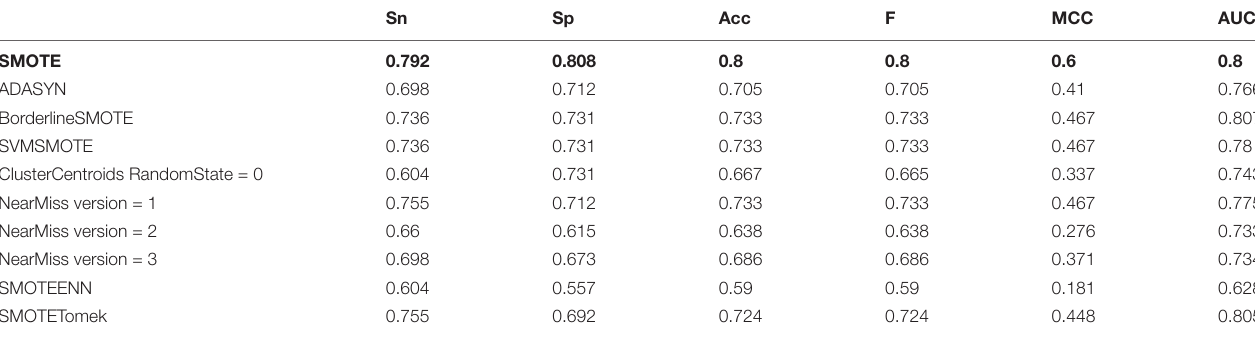
TABLE 4 | The prediction result of the model established by different data imbalance processing methods. Sn Sp Acc F MCC AUC SMOTE 0.792 0.808